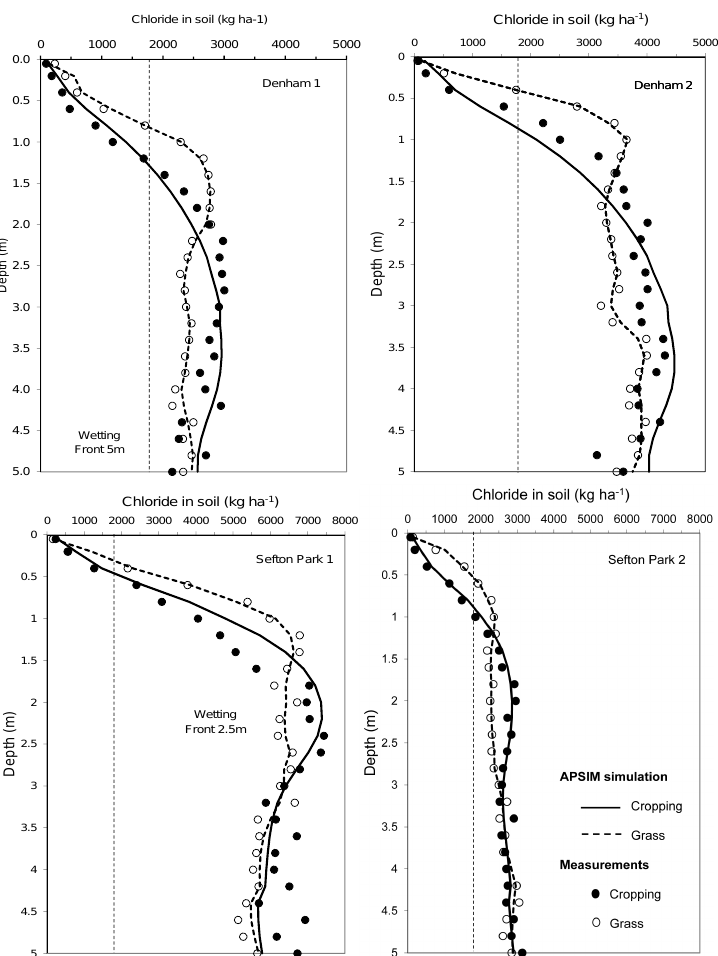
Fig. 3. Measured and APSIM simulations of normalised chloride in soil (kgha − 1 ) with depth at (a – b) Denham and (c – d )Sefton Park for cropping and grass control. The 50% reduction in water extraction for durum wheat is shown at 1000mgkg − 1 soil chloride at 1.0m depth (Dang et al., 2008), equivalent to 1800kgha − 1 assuming bulk density of 1.5tm − 3 and have been adjusted for equal mass balance for land uses within each